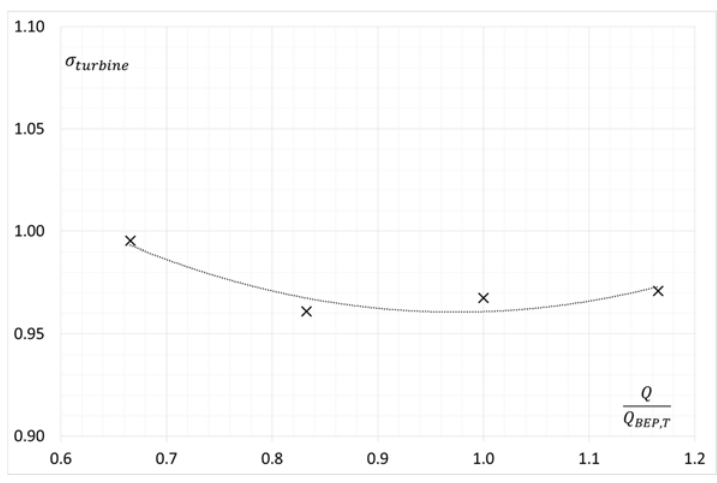
Figure 7. Slip factor vs mass flow rates.